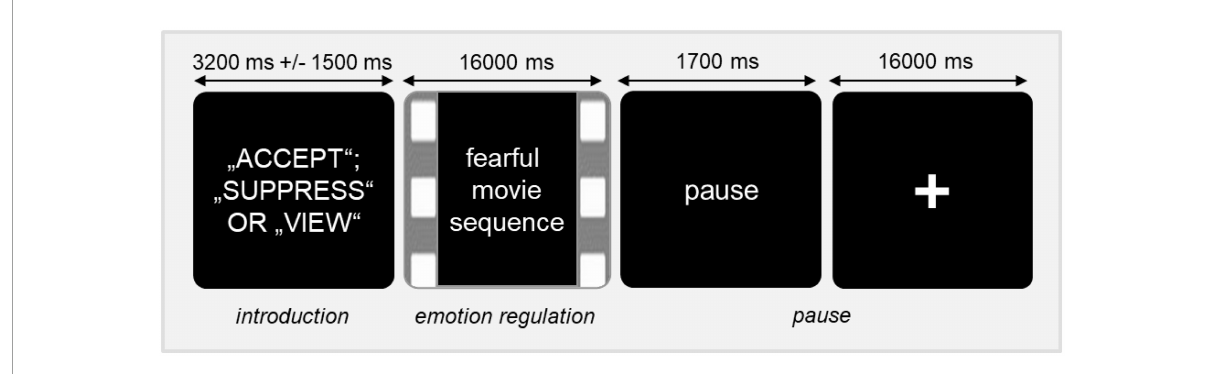
FIGURE1 Schematic illustration of the experimental